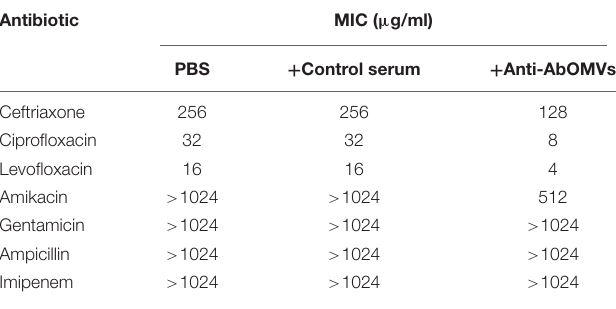
TABLE 1 | Determination of MIC values for the Ab112 strain when anti-AbOMV serum was used together with different types of antibiotics. Antibiotic MIC ( µ g/ml) PBS + Control serum +